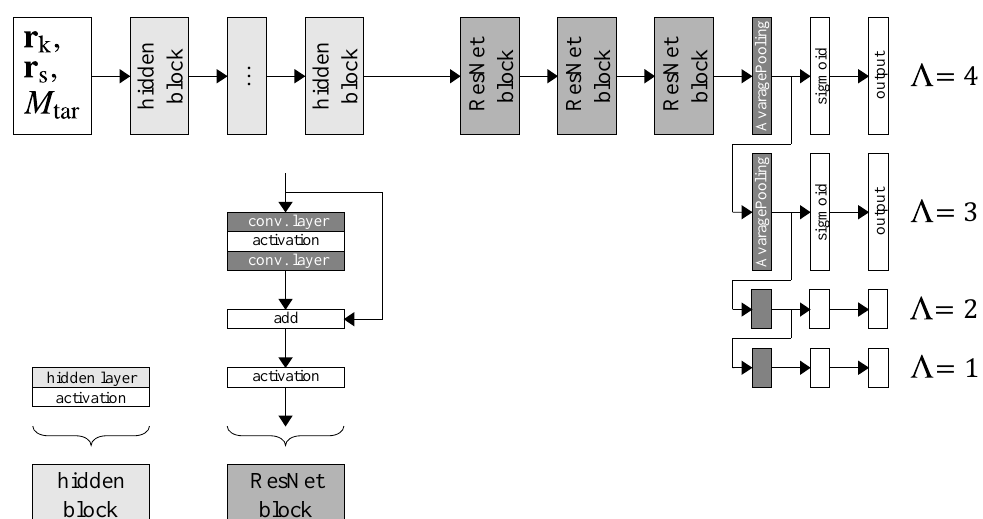
Figure 5. Predictor’s artificial neural network (ANN) topology (simplified).